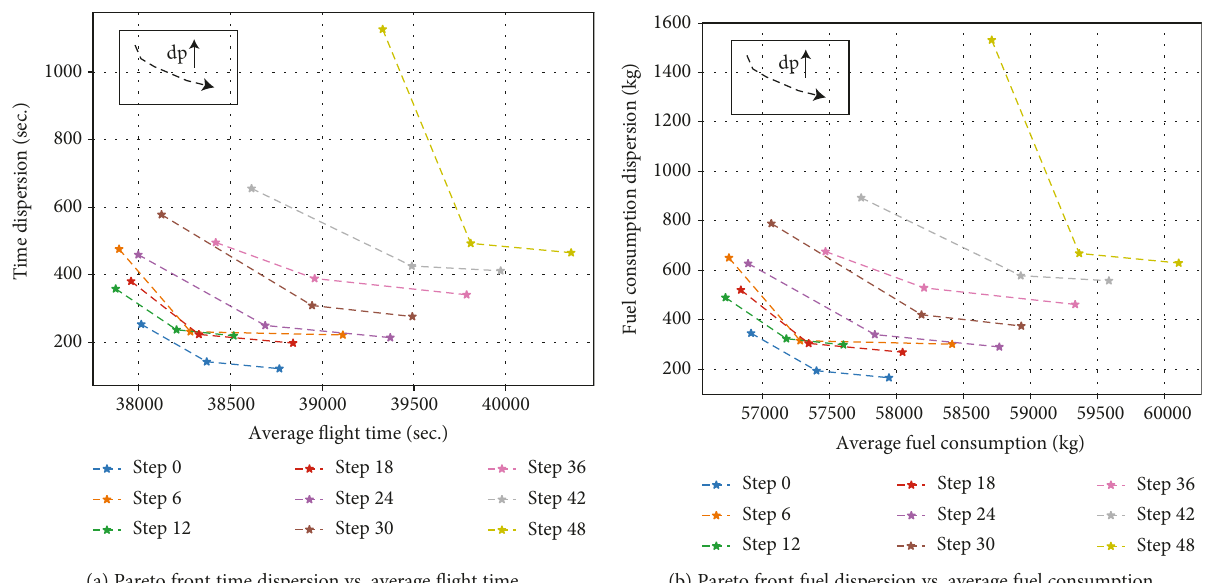
Figure 11: EGLL to SBGL results trade-o ff solutions of the problem: dispersion vs. dp values; and fl ight times/fuel consumption vs. dispersion.